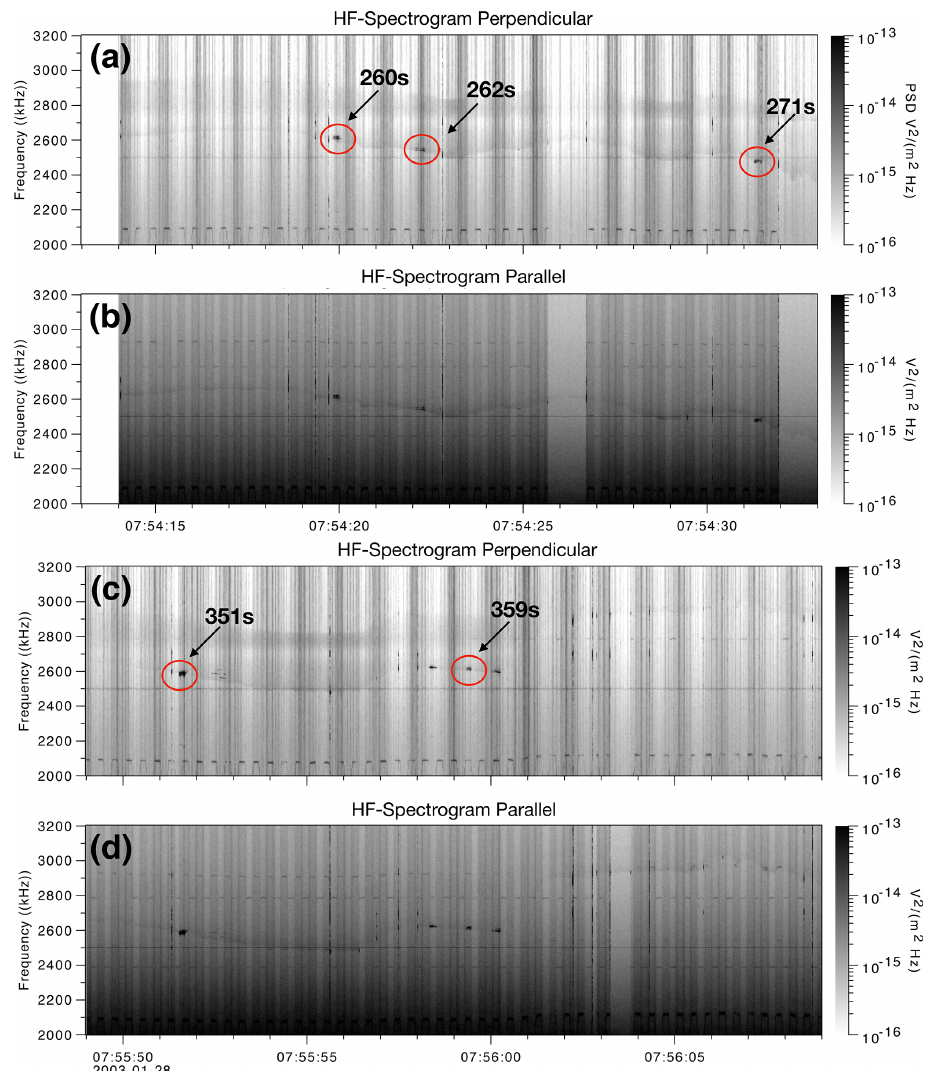
Figure 2. The 2000–3200kHz spectrograms of perpendicular ( upper panels a and c) and parallel ( lower panels b and d) HF electric fields for two time intervals during the HIBAR rocket flight, 07:54:18–07:54:33UT and 07:55:49–07:36:04UT, showing the plasma frequency cutoff as a lower bound in the perpendicular and parallel spectrograms and the upper-hybrid frequency cutoff as an upper bound in the perpendicular spectrograms. Red circles indicate five Langmuir wave bursts used for detailed